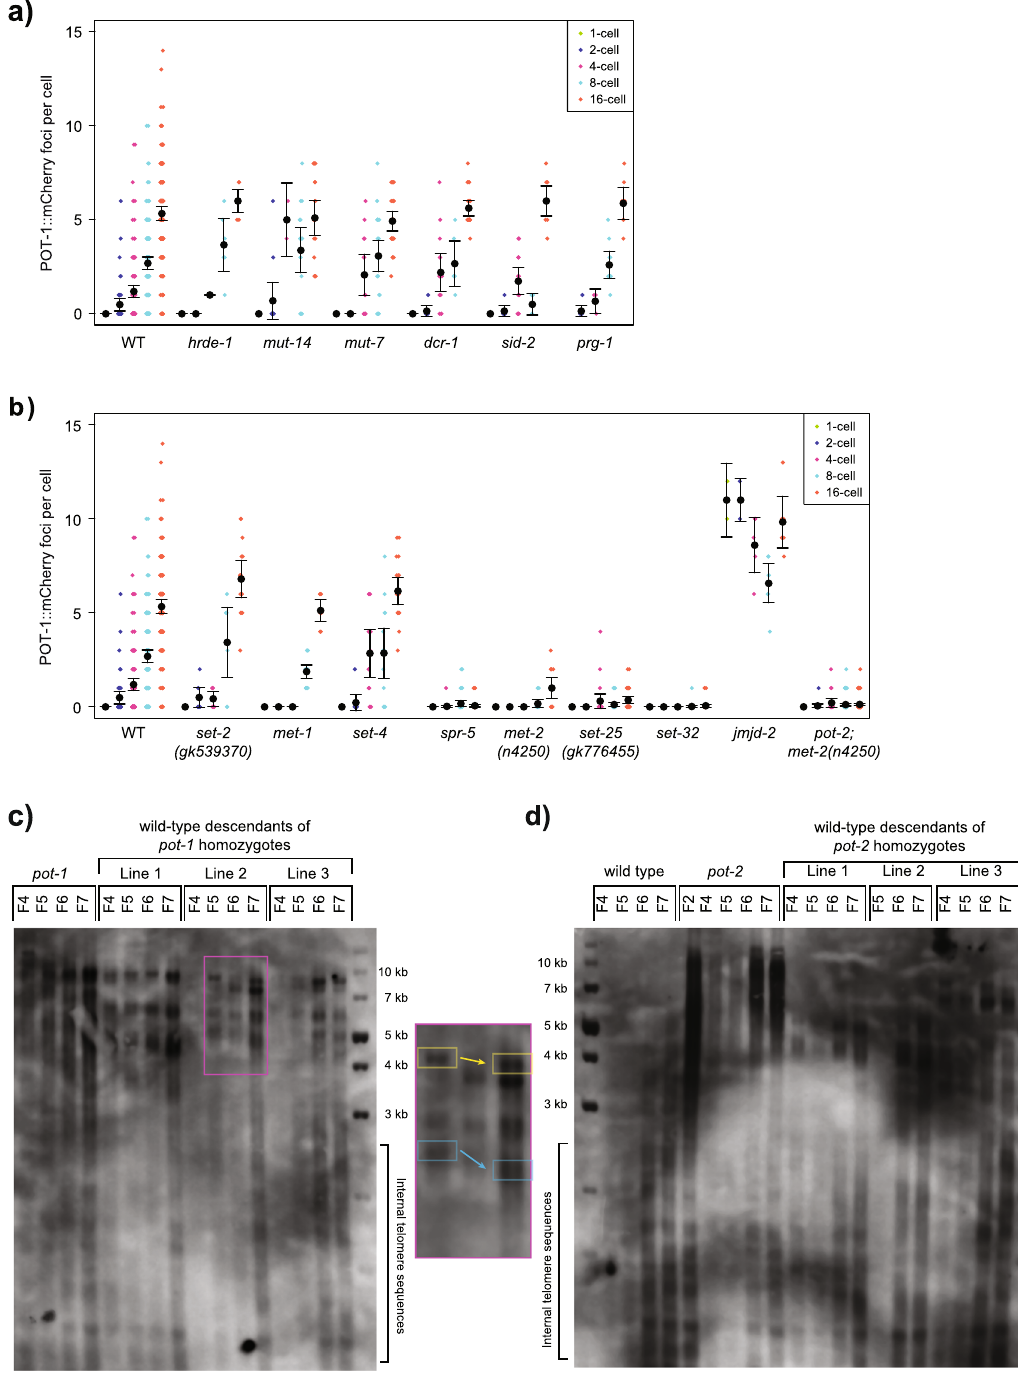
Fig. 3 Pot1 foci number is epigenetically affected by genes involved in H3K9 methylation. a , b Quanti fi cation of POT-1::mCherry foci in nuclei of F2 embryos derived from crosses of pot-1::mCherry males to hermaphrodites mutant for small RNA genes ( a ) or chromatin genes ( b ). c , d Southern blot using DNA from the genetically wild-type descendents of crosses between wild-type and pot-1 ( c ) or pot-2 ( d ) mutant worms. The portion of the pot-1 blot indicated by the magenta square is shown at higher detail to the right. Corresponding colored squares show telomere shortening across three generations. Error bars are 95% con fi dence factor mut-7 and found it had normal levels of Pot1 foci epistatic to pot-2 by creating pot-2; met-2 double mutant (Supplementary Fig. 3b), consistent with normal levels of Pot1 hermaphrodites and observed reduced levels of Pot1 foci in F2 foci in the F2 progeny of mut-7 gametes (Fig. 3a). In contrast, we embryos created from crosses with pot-1::mCherry males (Fig. 3b, created pot-1::mCherry strains that were homozygous mutant for ANOVA p < 10 − 15 ). As pot-1 or pot-2 mutants possess gametes that give rise to either met-2 or set-25 and observed dramatic reductions in levels cross-progeny in which levels of Pot1 foci are altered for multiple of Pot1 foci (Supplementary Fig. 3b). We next asked if met-2 is